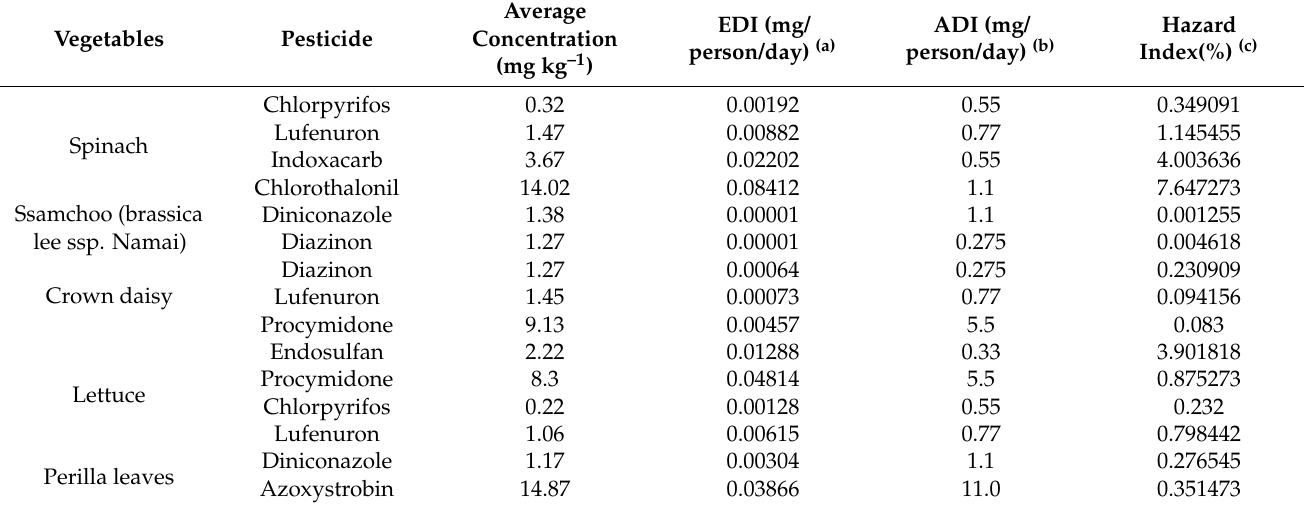
Table 6. Risk assessment of pesticides violating the MRLs in 5 main leafy